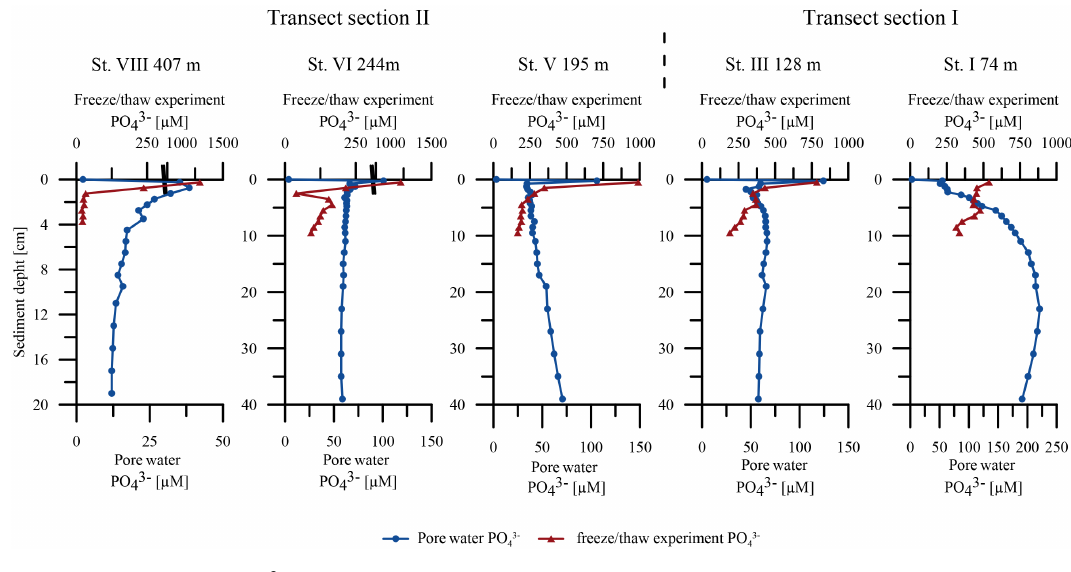
Figure 7. Comparison of porewater PO 3 − concentrations before (blue) and after the freeze–thaw experiments (red) in µmolL − 1 . 4